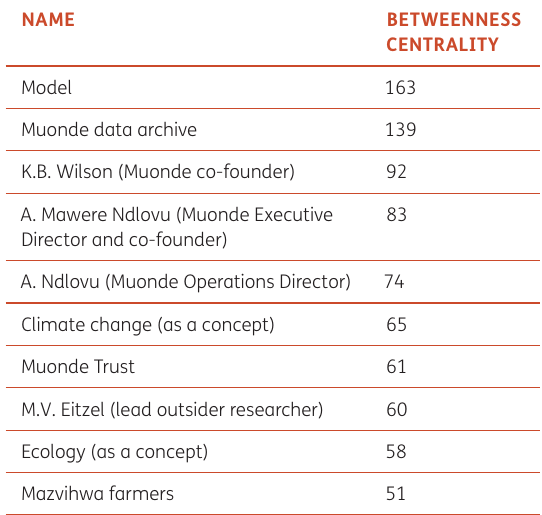
Table 4 Network centrality measures for bridging elements that facilitated the most connections with other elements (specifically, those with the 10 highest betweenness centrality scores) in the modeling